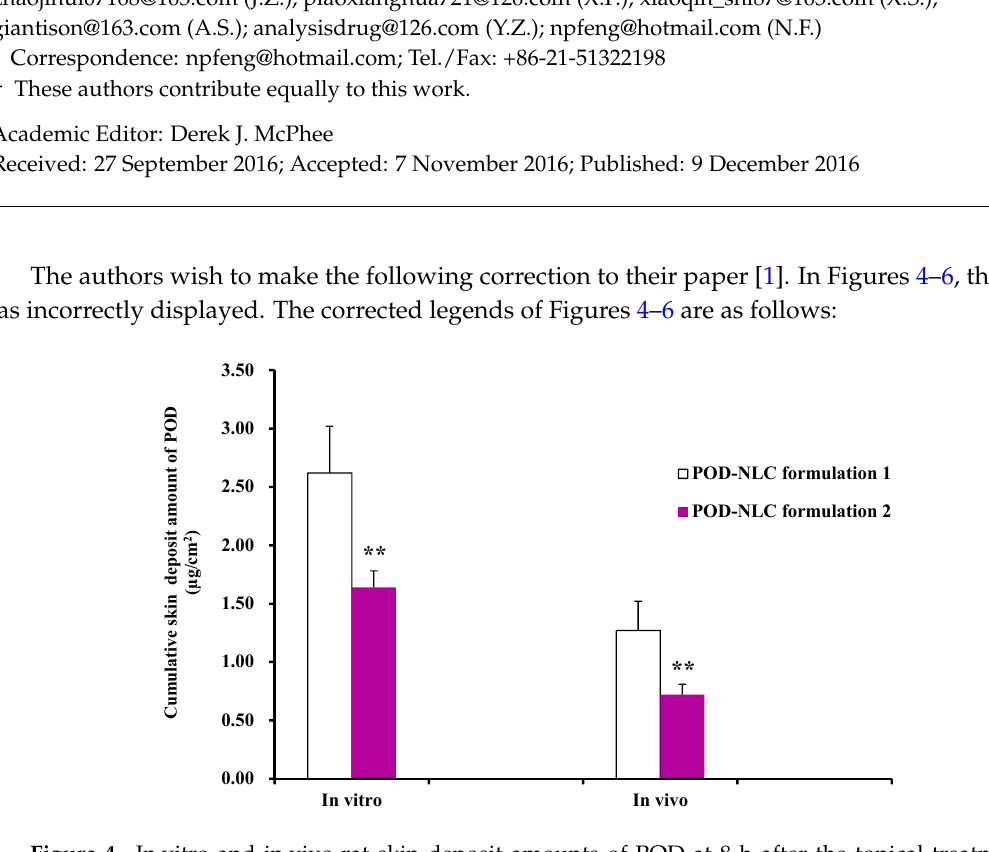
Figure 4. In vitro and in vivo rat skin deposit amounts of POD at 8 h after the topical treatment of POD-NLC formulation 1 or POD-NLC formulation 2 . Note: “**” represents p < 0.01 compared with POD-NLC formulation 1 .